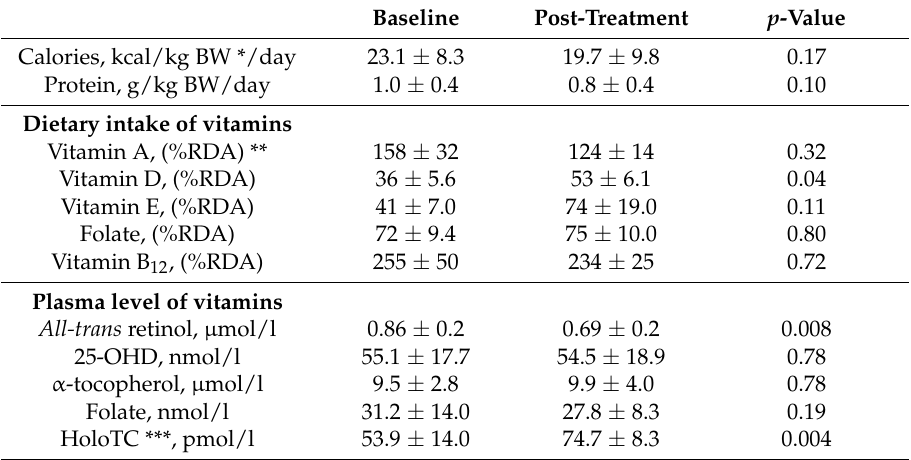
Table 2. Dietary intake and plasma level of vitamins at baseline and post-treatment. Baseline